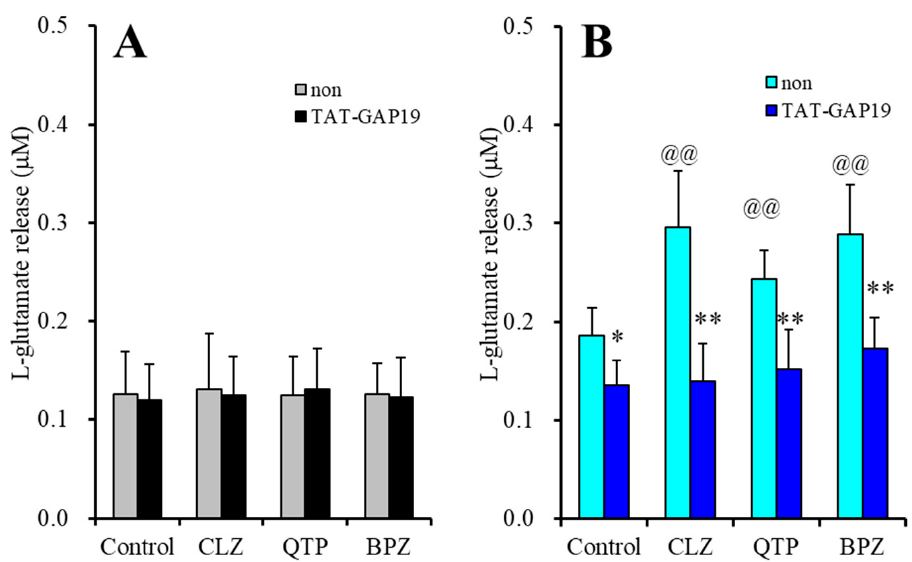
Figure 4. Effects of selective Cx43 inhibitor, N-terminal transactivator of transcription GAP19 (TAT-GAP19) on stimulatory effects of antipsychotics, CLZ (30 μ M), QTP (10 μ M) and BPZ (3 μ M), on basal ( A ) and FCHK-evoked ( B ) astroglial L -glutamate releases. Ordinate: mean ± SD ( n = 6) of astroglial L -glutamate release ( μ M). Light and dark color columns indicate the incubation without (non) and with TAT-GAP19, respectively. * p < 0.05, ** p < 0.01: relative to non, @@ p < 0.01 relative to control by MANOVA with Tukey’s post-hoc test.